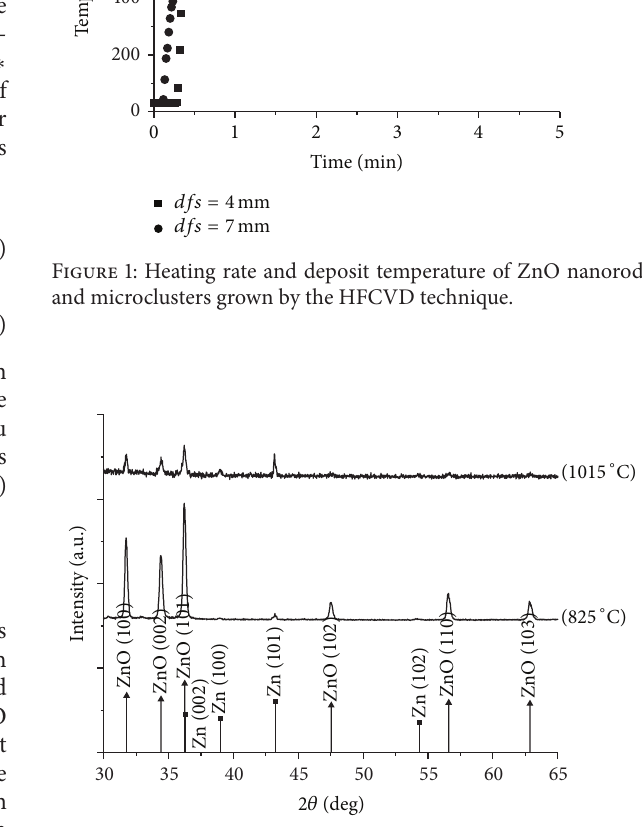
Figure 2: XRD spectra of the Zn-ZnO nanorods and microclusters deposited at 825 and 1015 ∘ C,